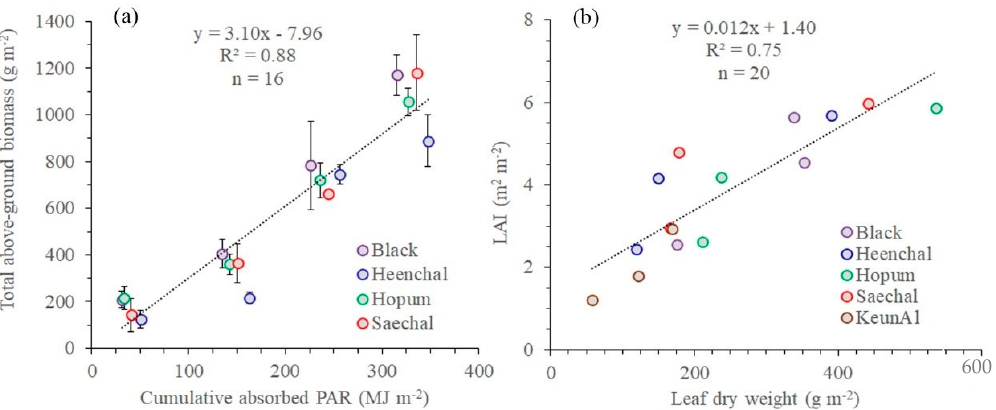
Figure 2. Determination of ( a ) a radiation use efficiency (RUE, ε = 3.1 g MJ − 1 ) and ( b ) a specific leaf area (SLA = 0.012 m 2 g − 1 ) for four (five in the case of SLA) barley cultivars. PAR and LAI represent photosynthetically active radiation and leaf area index.